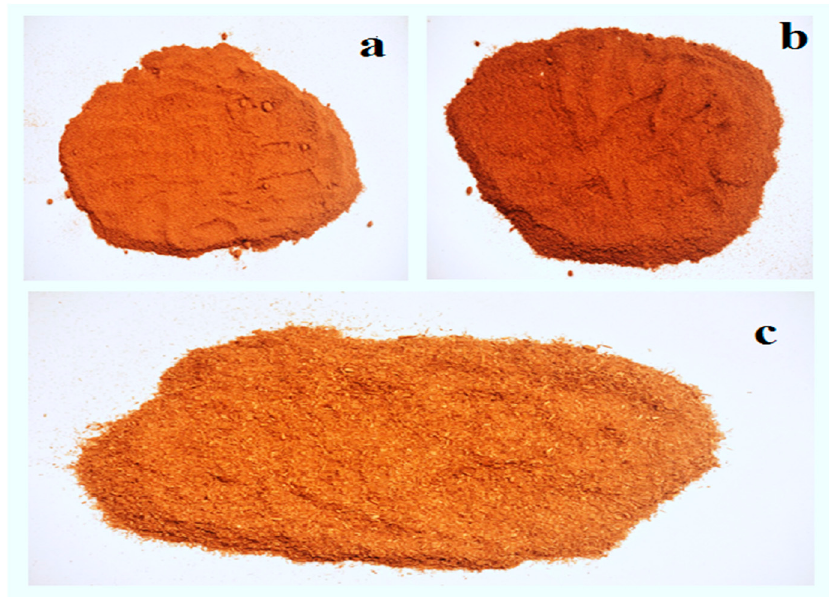
Figure 1. Saw-dust of weight densities ( a ) 200 kg/m 3 ( b ) 250 kg/m 3 and ( c ) 300 kg/m 3 .